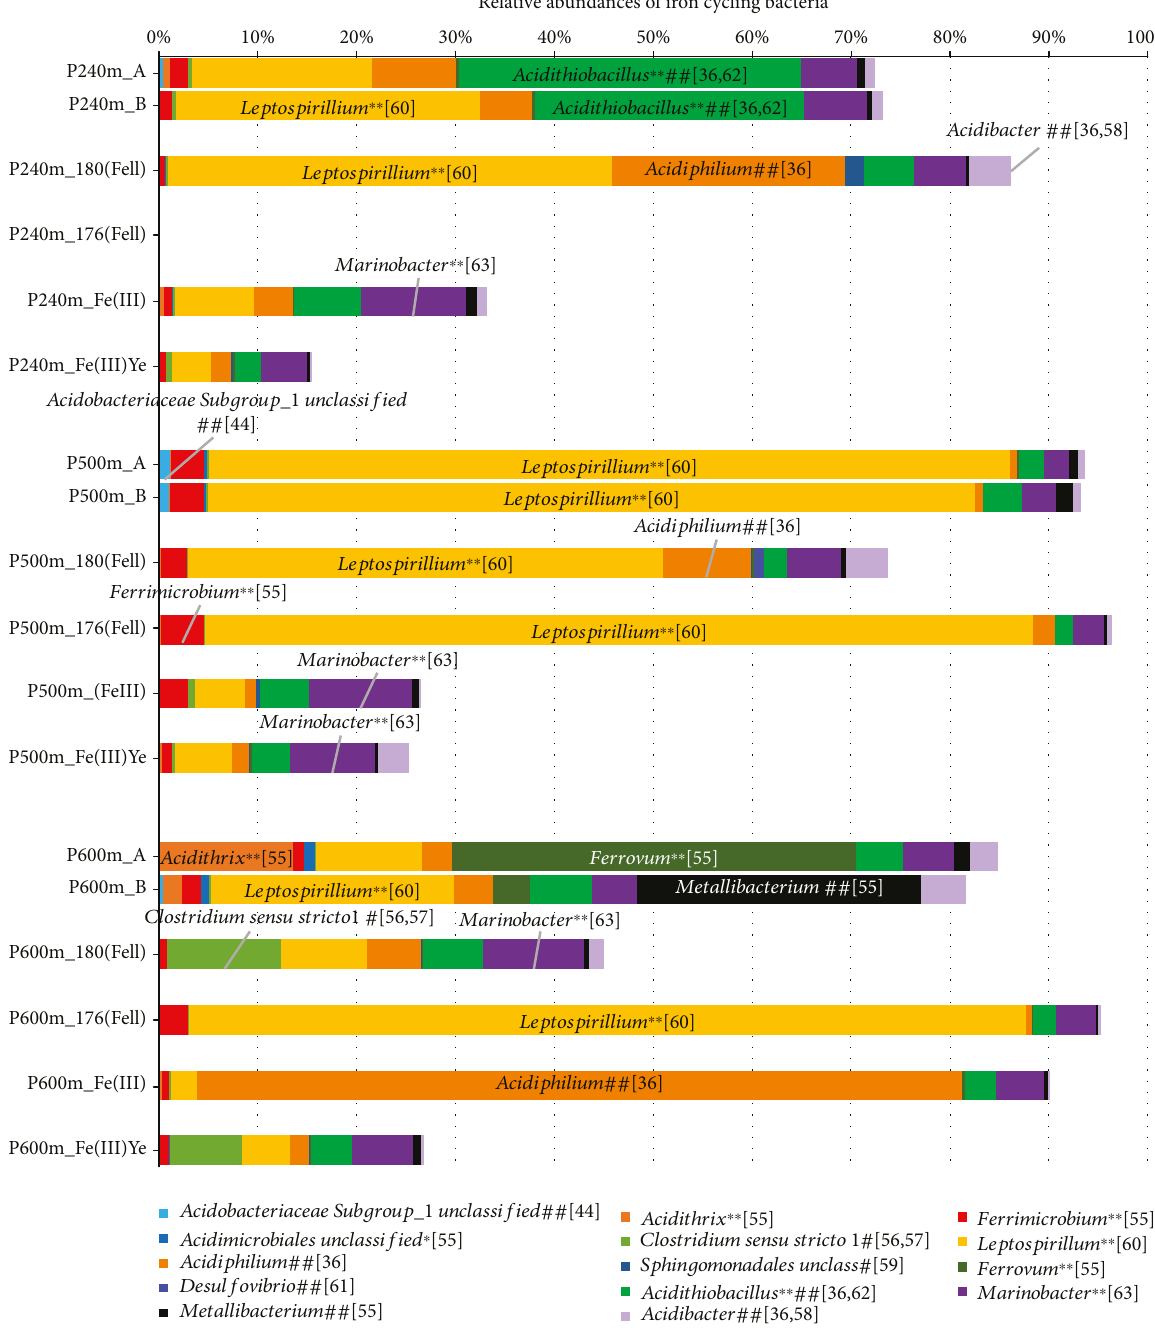
Figure 5: Relative abundances of iron cycling bacteria in the mine water samples and enrichments. ∗∗ indicates iron oxidation. ∗ Iron oxidizers identi fi ed within this taxonomic group. ## Iron reducer. # Iron reducers identi fi ed within this taxonomic group, according to literature [36, 44, 56 – 63]. The complete bacterial diversity is found in Table